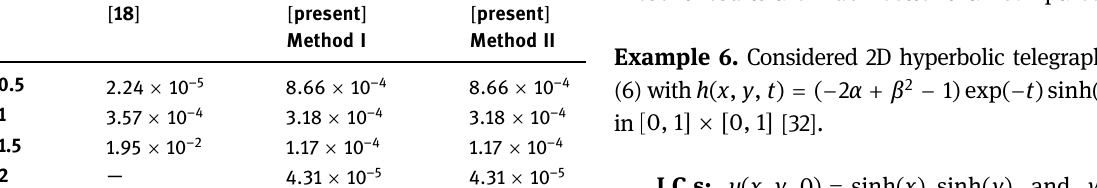
Table 10: Comparison of maximum absolute error at di ff erent time levels for = α 20 , = β 10 , = N 101 , = τ 0.5 , and = t Δ 0.0001